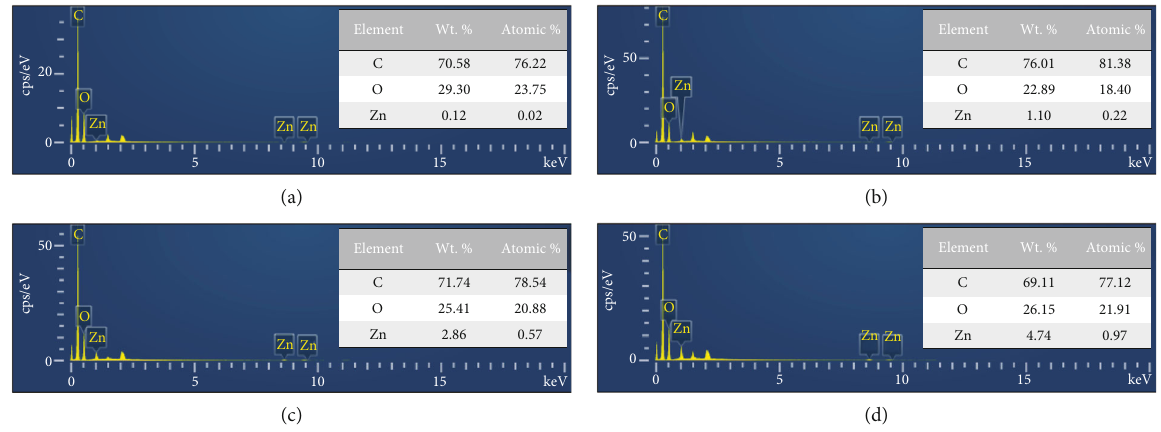
Figure 2: EDS spectrum of PVA/ZnO nano fi bers with di ff erent relative concentrations of ZnO NPs: (a) 0%, (b) 1%, (c) 4%, and (d)